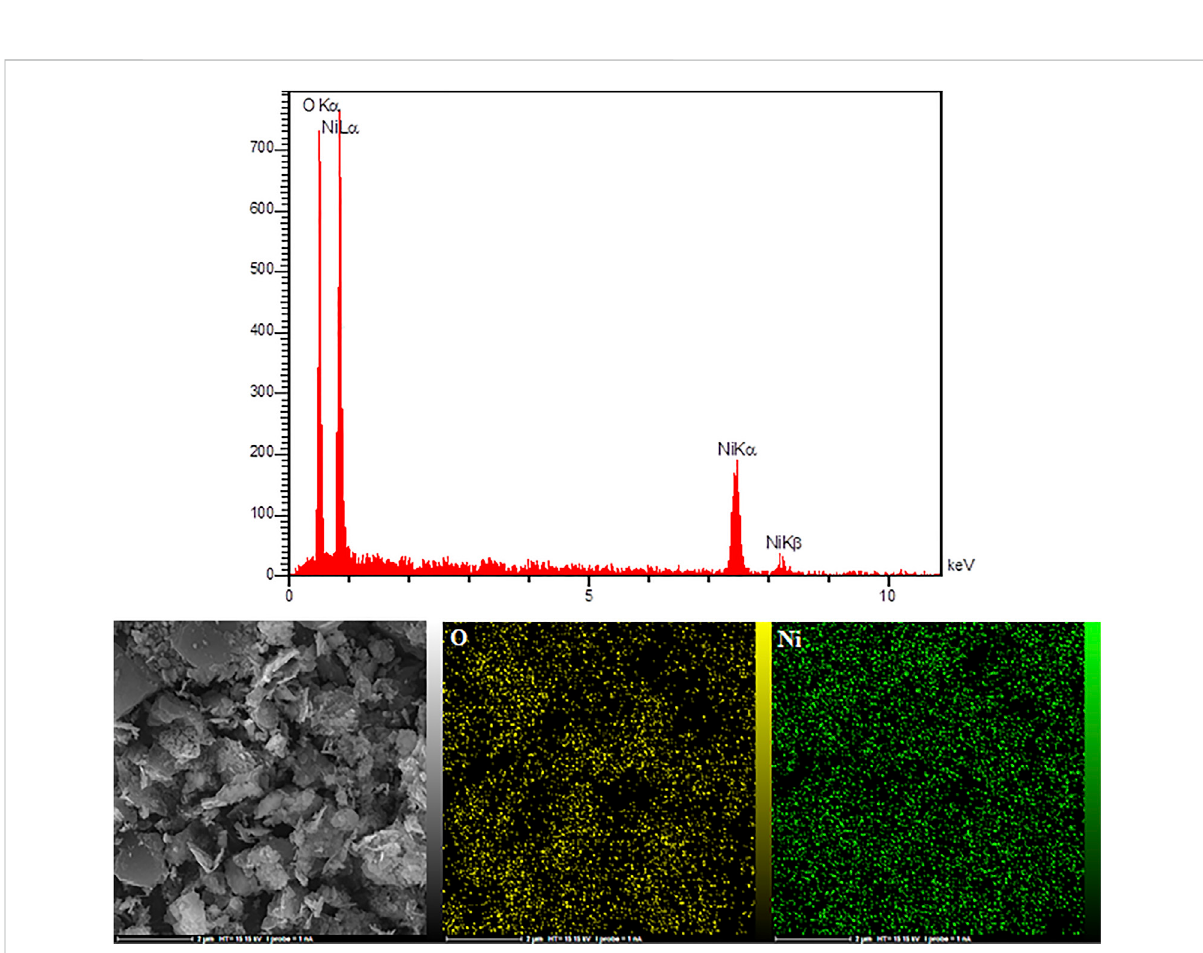
FIGURE 3 EDX spectra and elemental mapping of